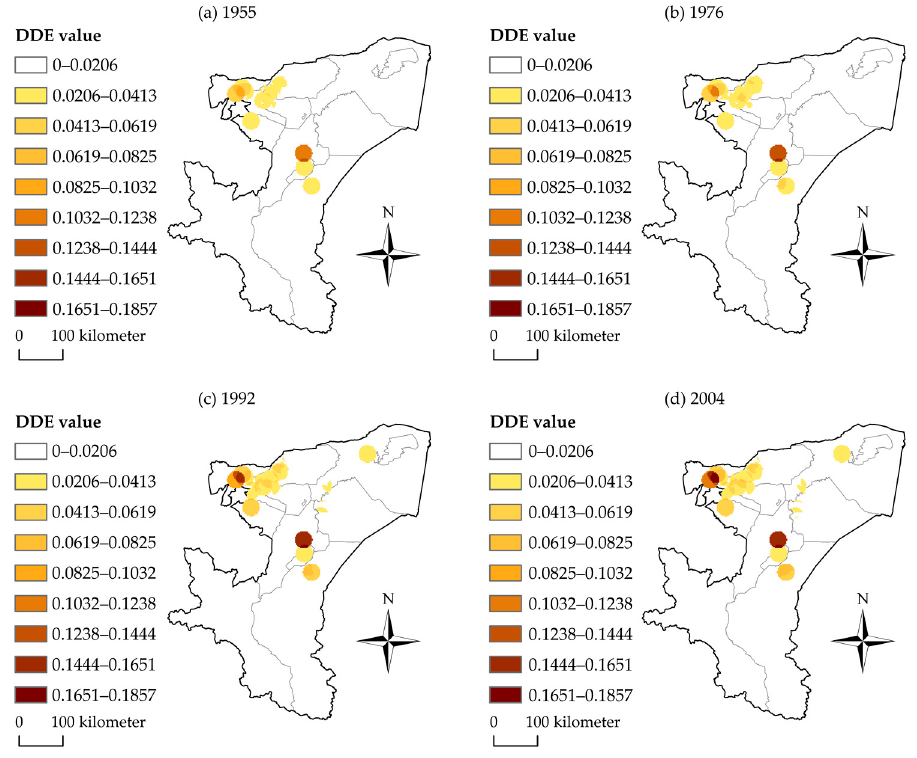
Figure 4. Dot density of mosque distribution from 1955 to 2004.